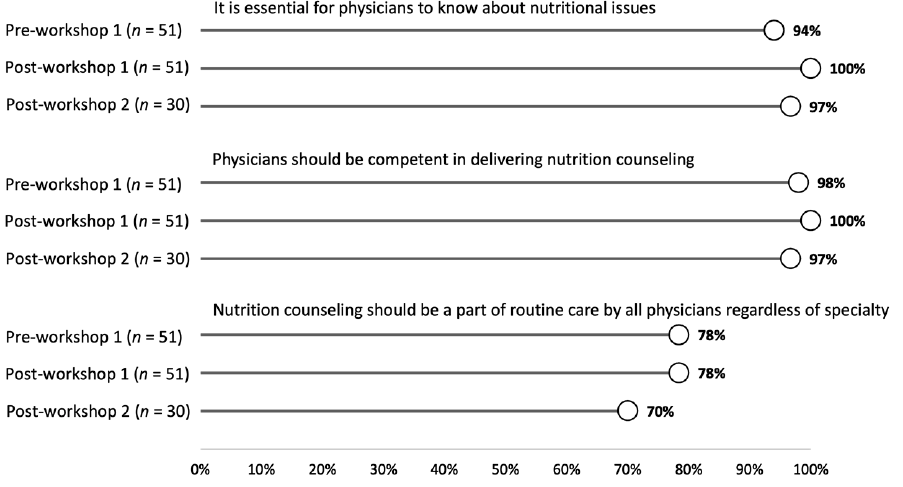
Figure 1. The percent of students who responded strongly agree or agree to each question at the pre-workshop 1, post-workshop 1, and post-workshop 2 time-points.